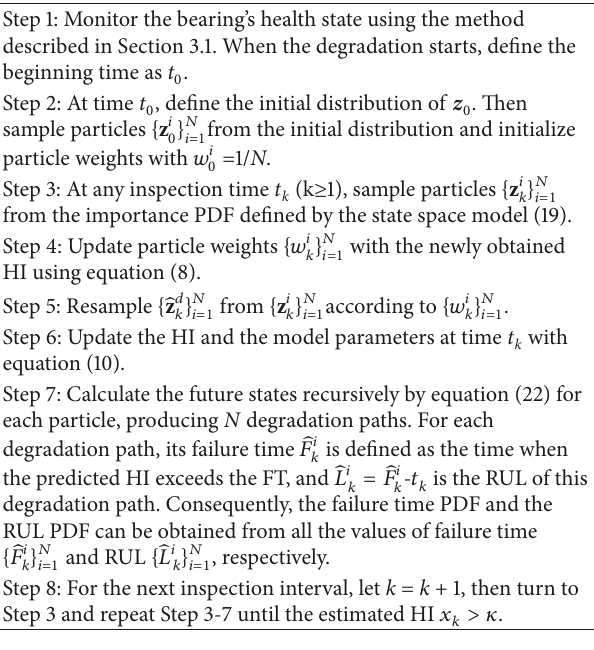
Table 1: Parameters update and RUL prediction process.